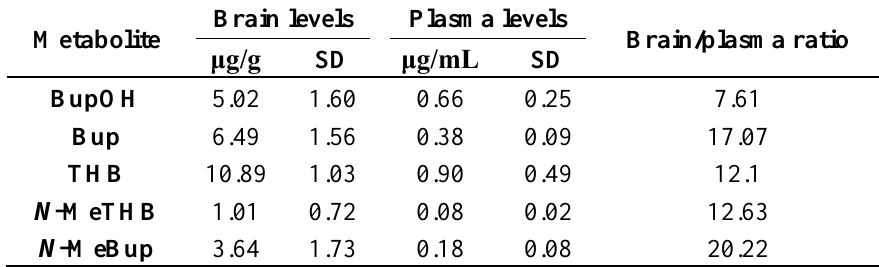
Table 3. The brain/plasma ratio of N -methylbupropion and metabolites in the guinea-pig 20 min post IP injection of 42 mg/Kg N -methylbupropion ( n = 5).